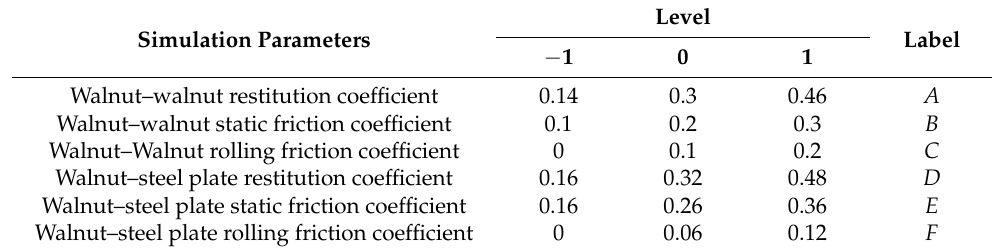
Table 2. Parameter lists of the Plackett–Burman